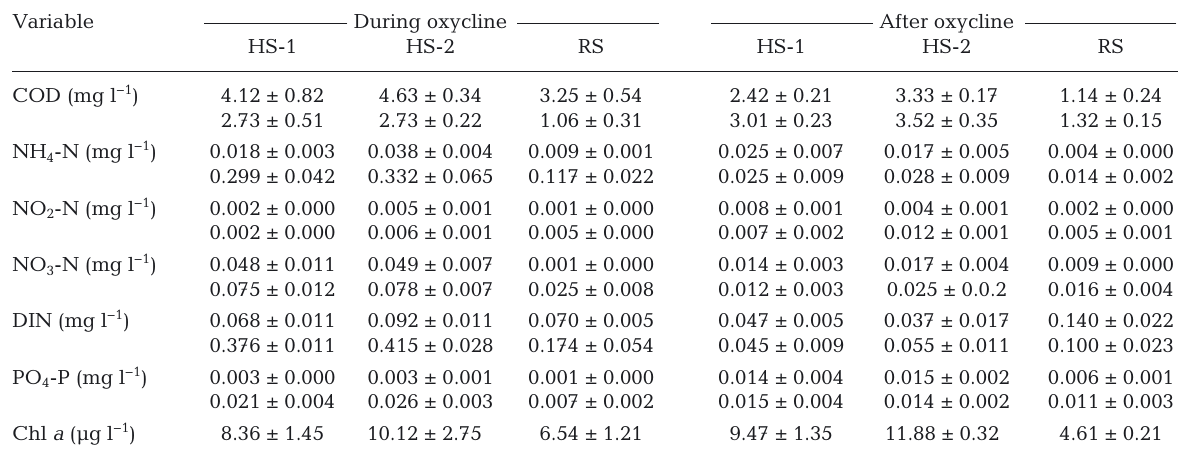
Table 2. Mean (±SD) changes in organic and inorganic variables during the oxycline and after its disappearance at the study sites. For each variable, the upper row are the values at 1 m depth and the lower row are values at the bottom. Chl a values are at a depth of 1 m. HS-1: hypoxic site 1; HS-2: hypoxic site 2; RS: reference site; COD: chemical oxygen demand; NH 4 -N, NO